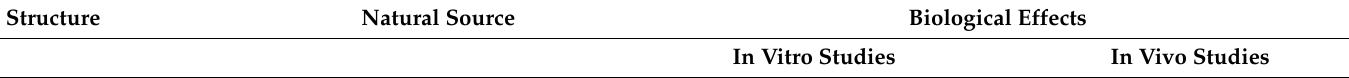
Table 2. Name, 2D structure, natural source and biological effects of natural PIs in MM.